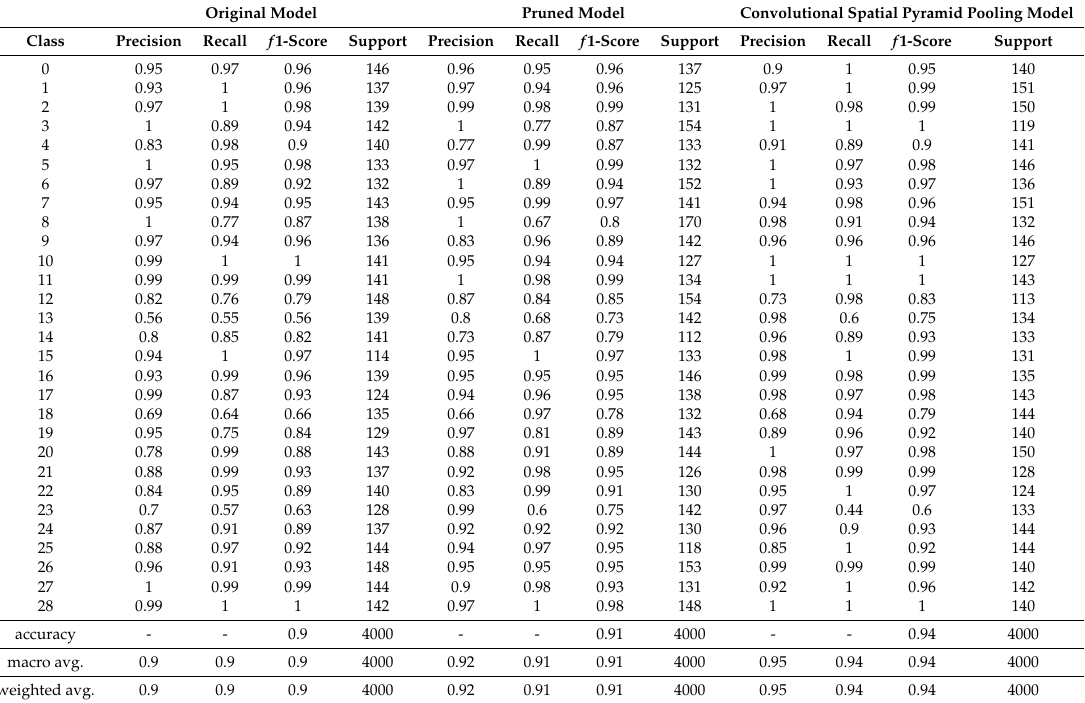
Table 5. Result Analysis of all the Proposed Models